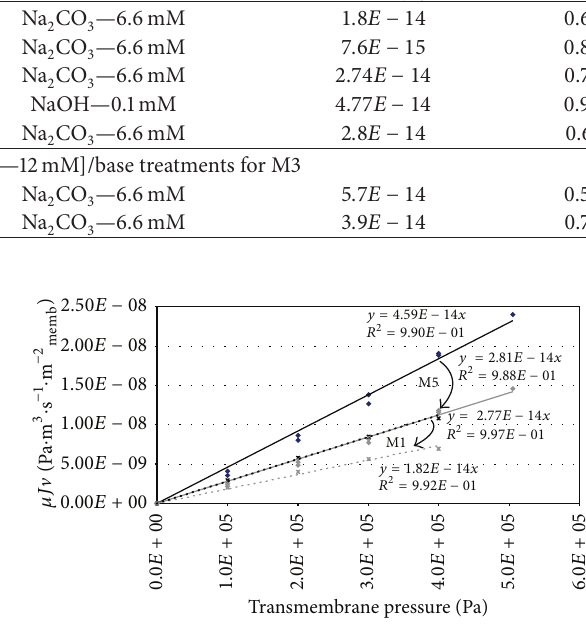
Hydraulic permeability Nature of the treatment